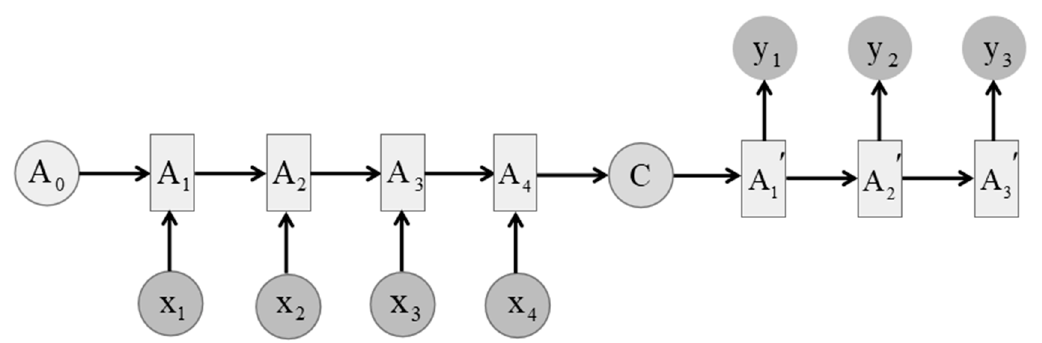
Figure 2. The structure diagram of the sequence-to-sequence (Seq2Seq) model.